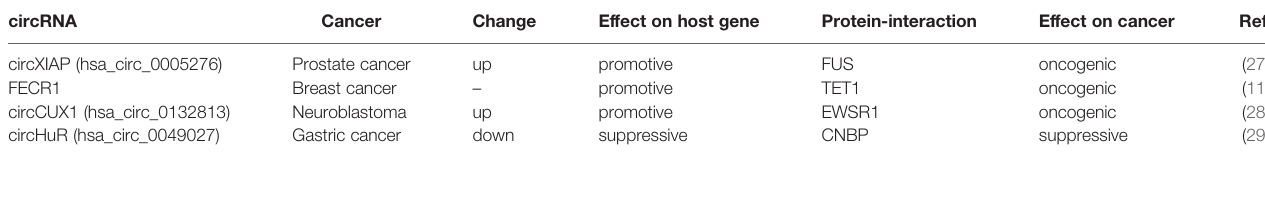
TABLE 2 | circRNAs regulate host gene transcription in human cancer. circRNA